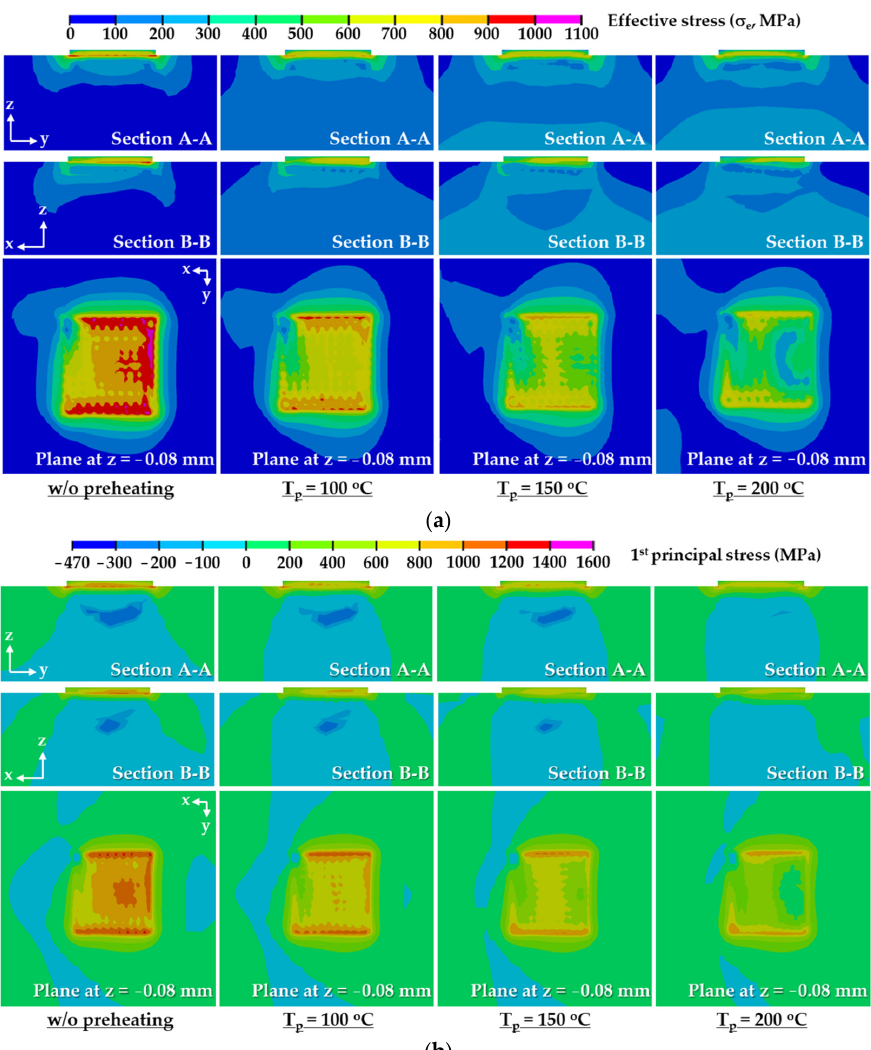
Figure 18. Residual stress for different preheating temperatures (after completion of the 3rd layer deposition): ( a ) effective stress distributions; ( b ) first principal stress distributions.